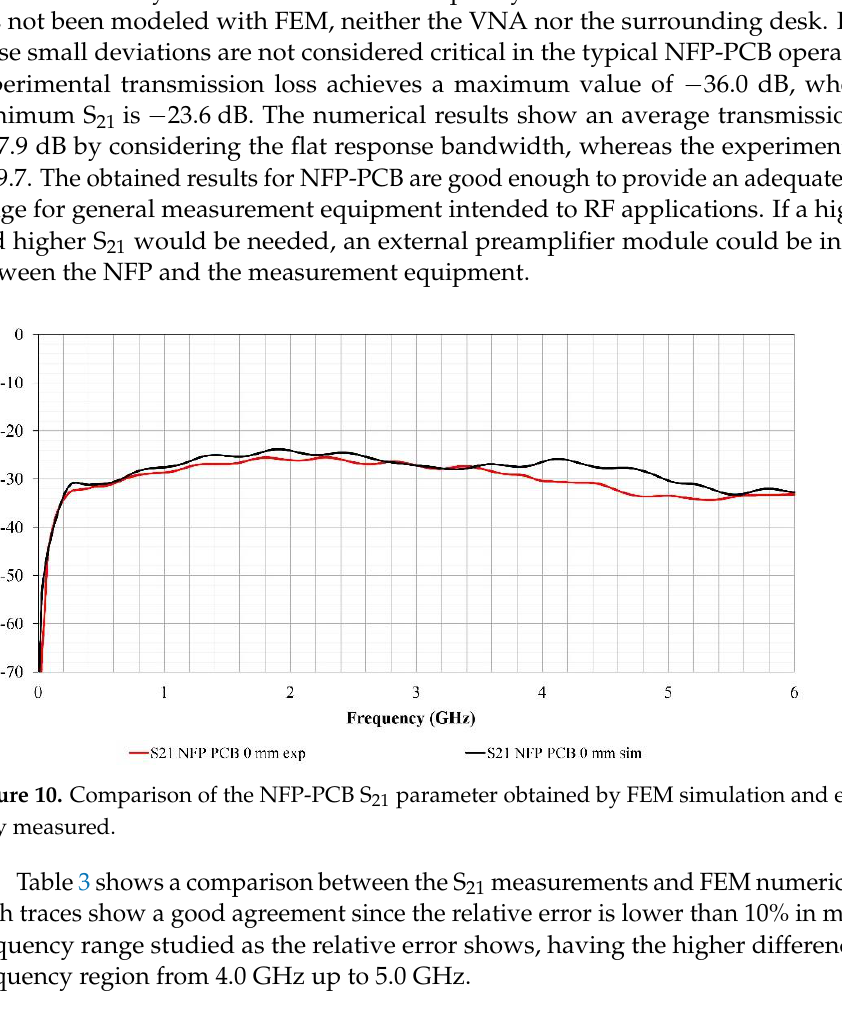
Table 3. Comparison between S 21 experimental and numerical results.